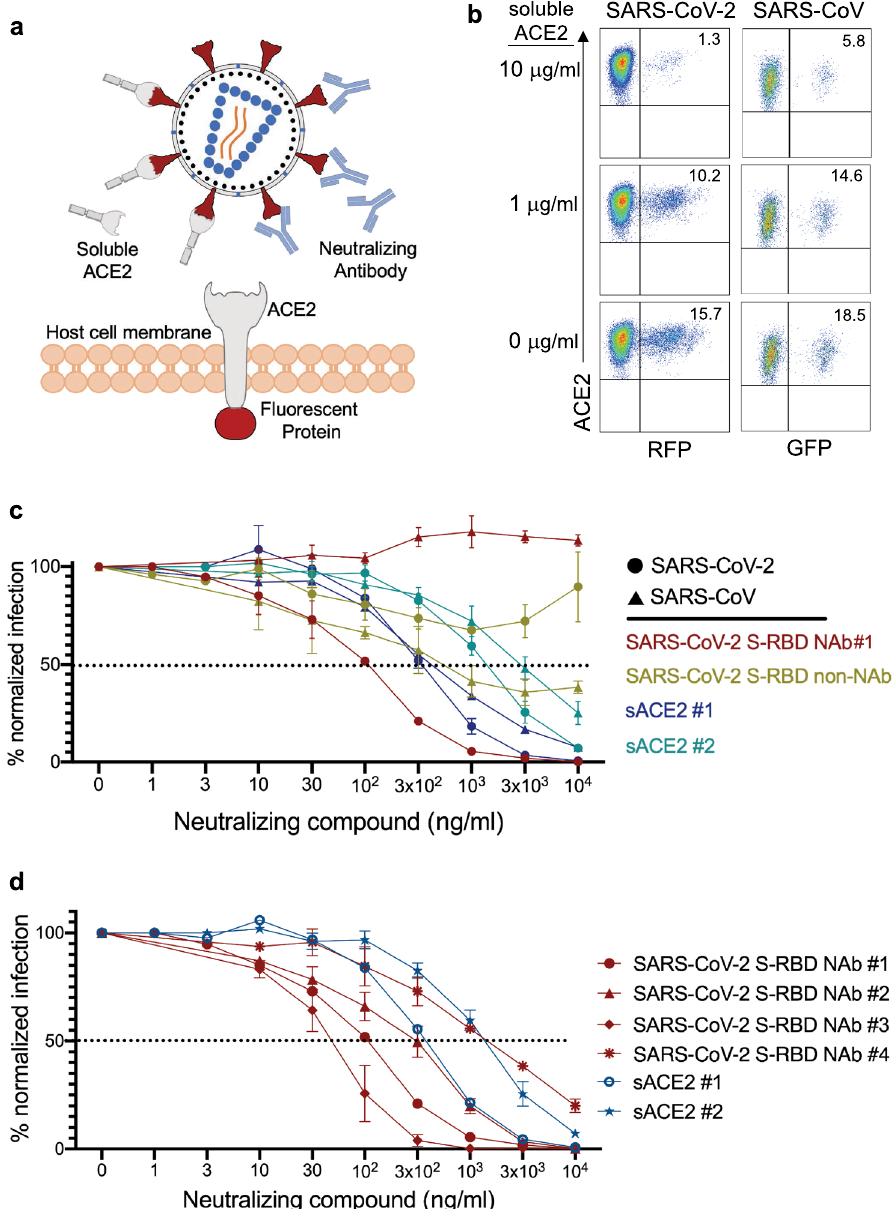
Fig. 4 Neutralization of SARS-CoV-2 and SARS-CoV pseudoviruses with soluble ACE2 and Nabs. a Illustration of spike-protein pseudovirus blocked by soluble ACE2 or neutralizing antibodies. b SARS-CoV-2 and SARS-CoV pseudovirus neutralization with soluble ACE2. SARS-CoV-2 RFP and SARS-CoV GFP pseudoviruses were pre-incubated with soluble ACE2 for 1 h and added to 293 cells expressing ACE2-IRES-GFP or ACE2-mKO2 fusion, respectively. c Neutralization of SARS-CoV-2 and SARS-CoV with S-RBD-speci fi c antibodies and soluble ACE2 (sACE2). Viruses were pre-incubated with antibodies (NAb#1 and SARS-CoV-2 S-RBD non-NAb) or soluble ACE2 (sACE2) proteins for 1 h at the concentrations shown and subsequently added to target cells. Expression of RFP was determined at day 3 post-infection. Infection percentages were normalized to negative controls which are the infection conditions with no blocking agent. Triangles and circles represent SARS-CoV and SARS-CoV-2 data, respectively. Red, green, blue and turquoise colored lines show SARS-CoV-2 S-RBD NAb#1, SARS-CoV-2 S-RBD non-NAb, soluble ACE2 #1 and #2, respectively. d Neutralization of SARS-CoV-2 pseudoviruses using 4 different S-RBD NAbs and two different soluble ACE2 proteins. NAb #1 and #4 were human antibodies whereas NAb #2 and #3 were mouse. Red lines represent antibodies while blue lines show soluble ACE2 molecules. Dot, triangle, square, asterisk, circle and star symbols indicate SARS-CoV-2 S-RBD NAb #1, #2, #3, #4, soluble ACE2 #1 and #2, respectively. Graphs in ( c ) and ( d ) represent three replicates of the experiments. Error bars indicate one standard deviation of mean